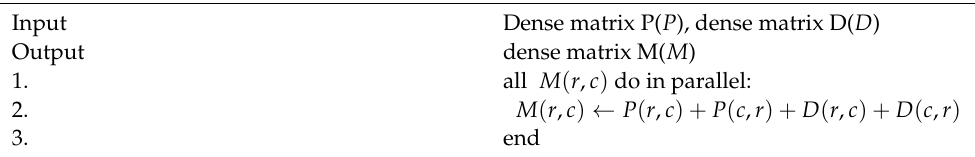
Algorithm 3. Parallel Construct Modified KKT Matrix (top-left